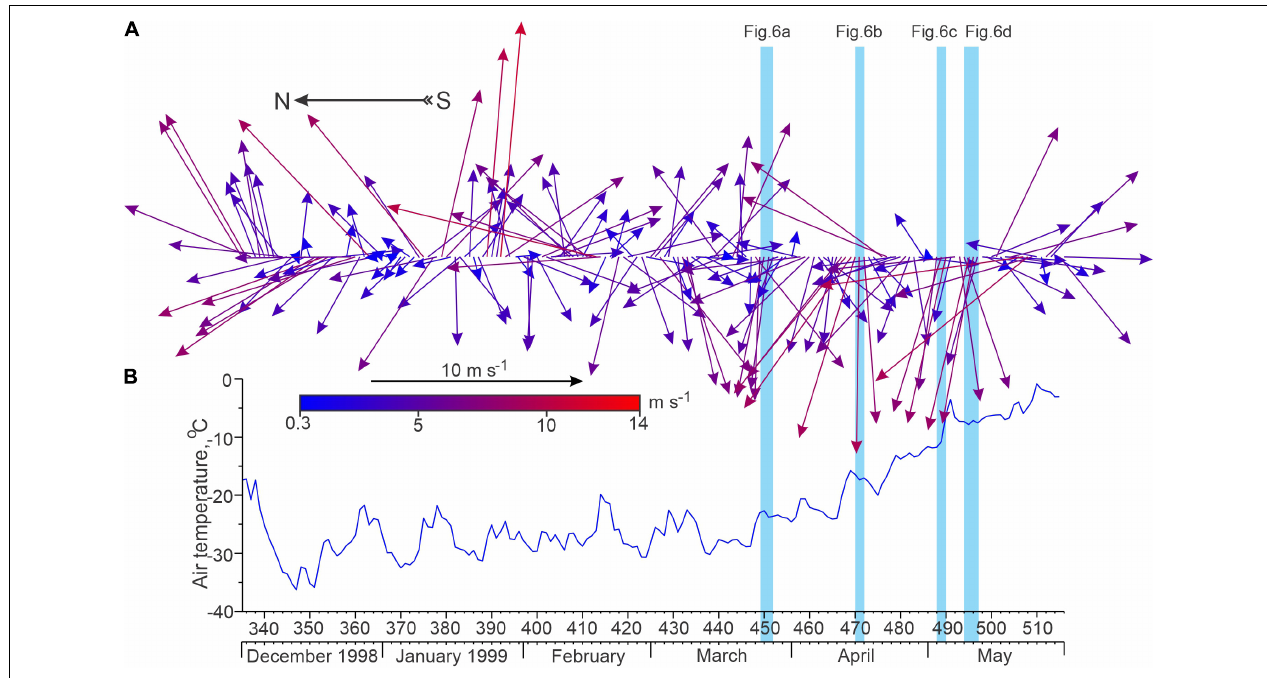
FIGURE 4 | Time series of (A) daily mean 10-m wind (arrows; m s − 1 ) and (B) 2-m air temperature (blue line; ◦ C) from 1 December 1998 to 31 May 1999 derived from ERA5 at the location of mooring Yana. Blue shading highlights periods of strong easterly winds that forced polynya openings as shown in Figures 6A–D .